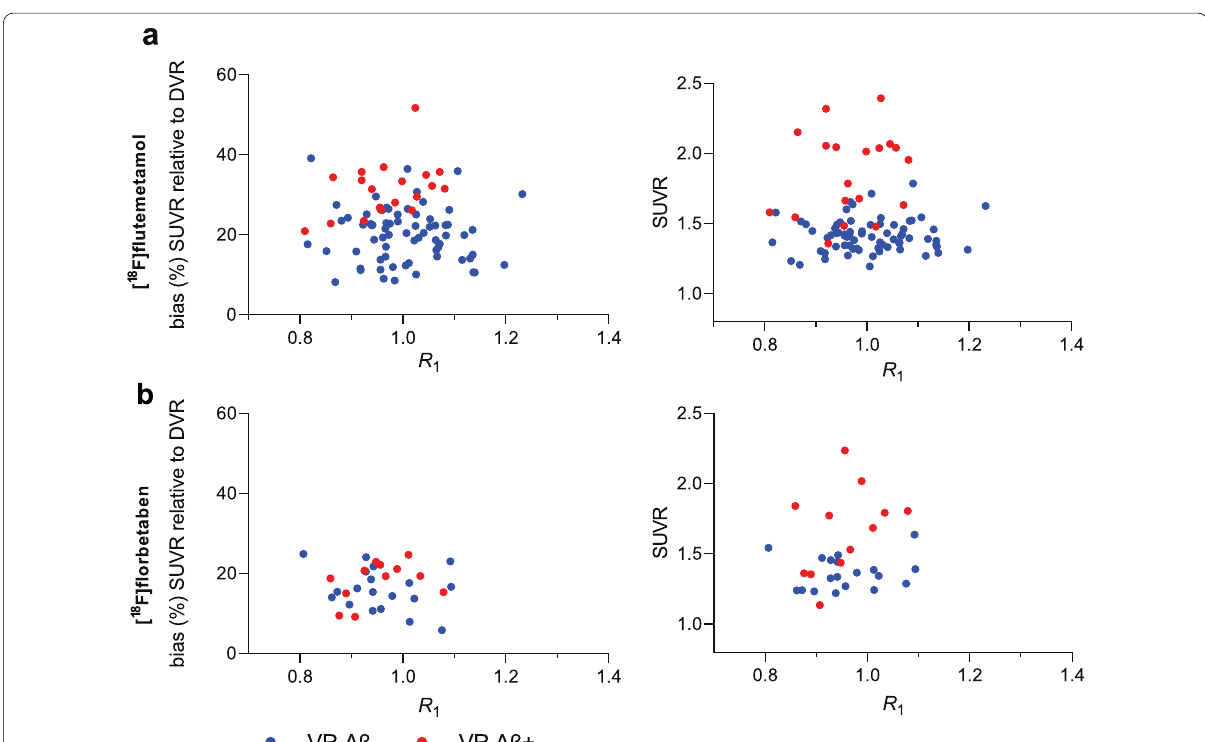
Fig. 3 Relationship between global cortical relative tracer delivery ( R 1 ) and amyloid burden . Correlation plots shown for a [ 18 F]flutemetamol and b [ 18 F]florbetaben. VR: visual